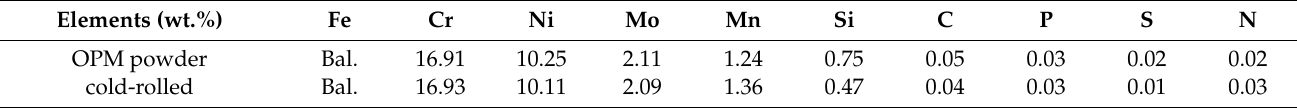
Table 2. Chemical compositions of OPM SS316L powder and cold-rolled